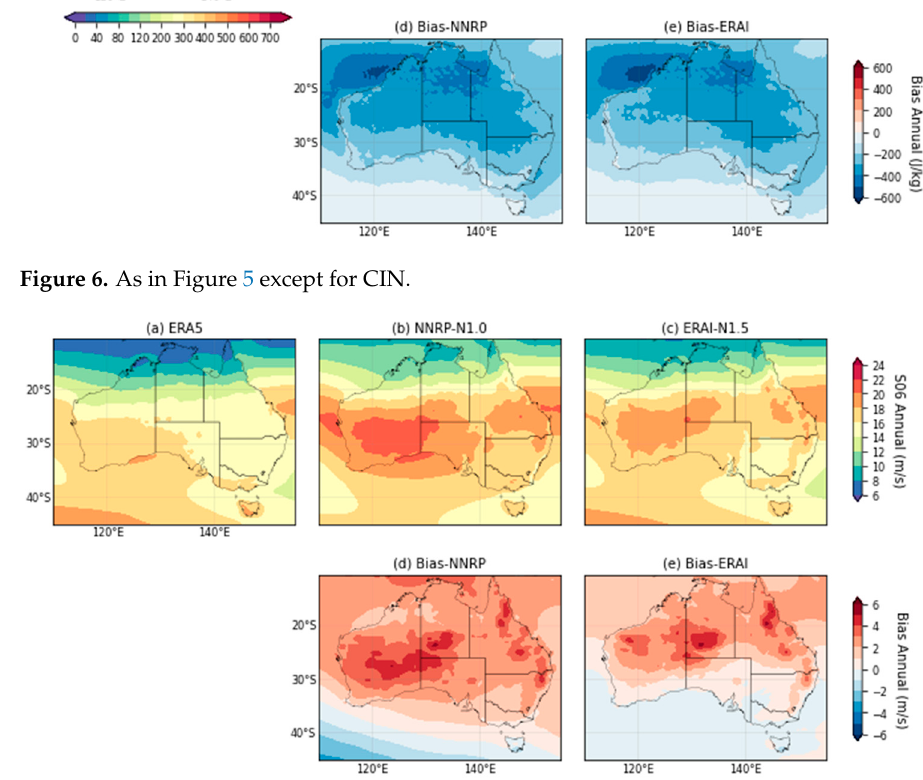
Figure 7. As in Figure 5 except for S06.